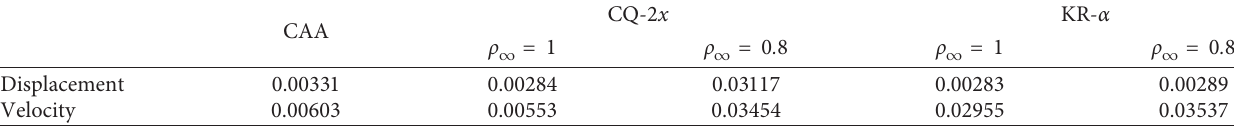
Table 3: Maximum displacement and velocity responses’ errors of the 200th DOF when n � 200.